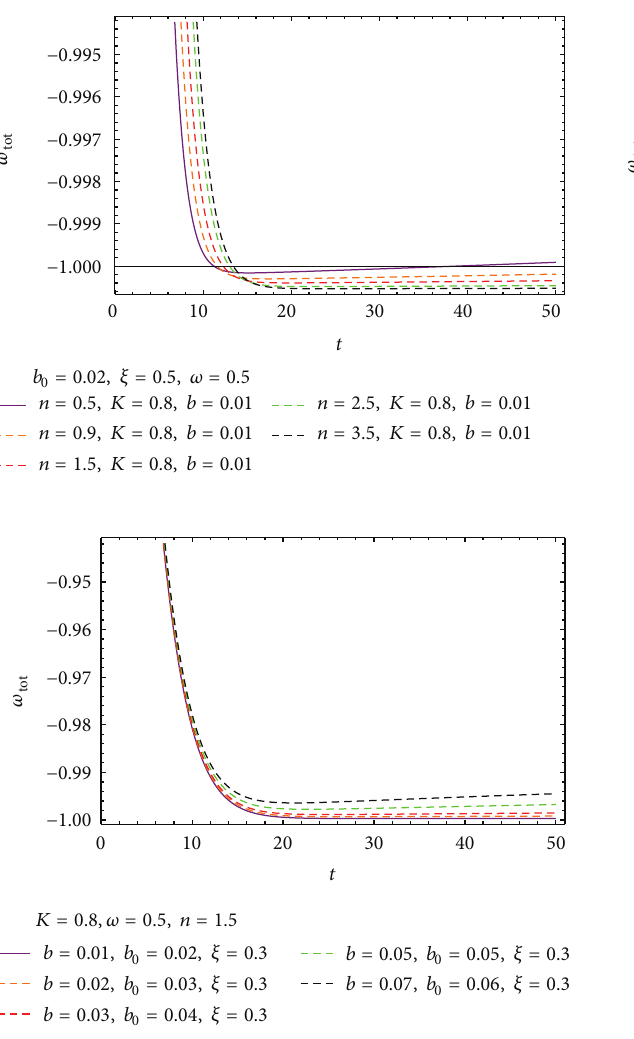
against 𝑡 for interacting barotropic fluid and viscous polytropic gas. tot